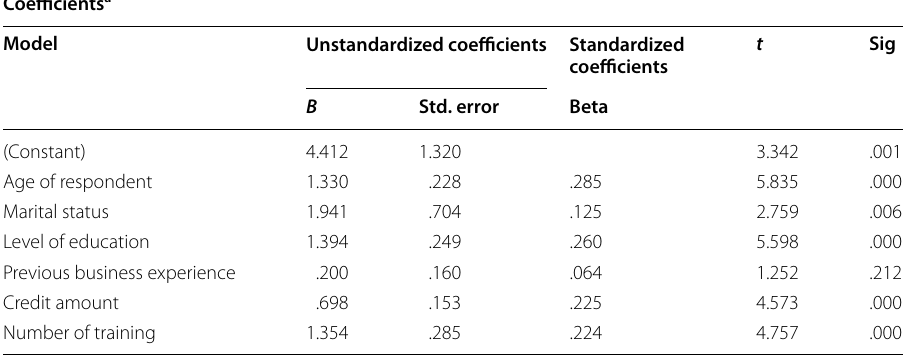
Table 1 Regression